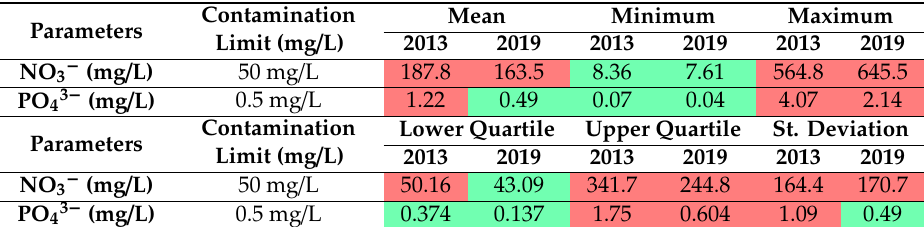
Table 2. Descriptive statistics of investigated